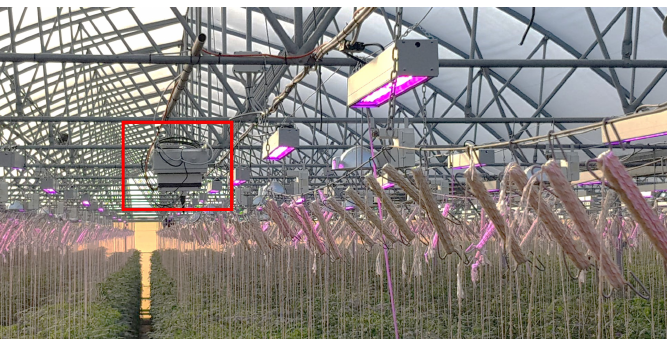
Figure 5. Sensors installed inside the greenhouse with the electrical cabinet containing the data monitoring unit hanged to the greenhouse cover.